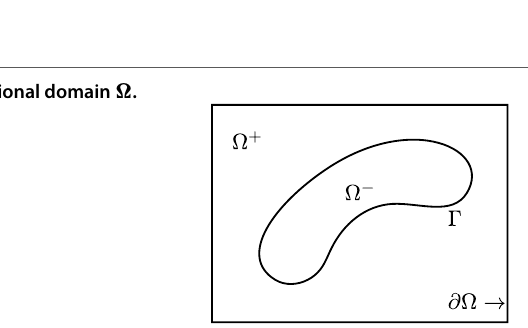
Figure 1 The geometry of the computational domain (cid:2)